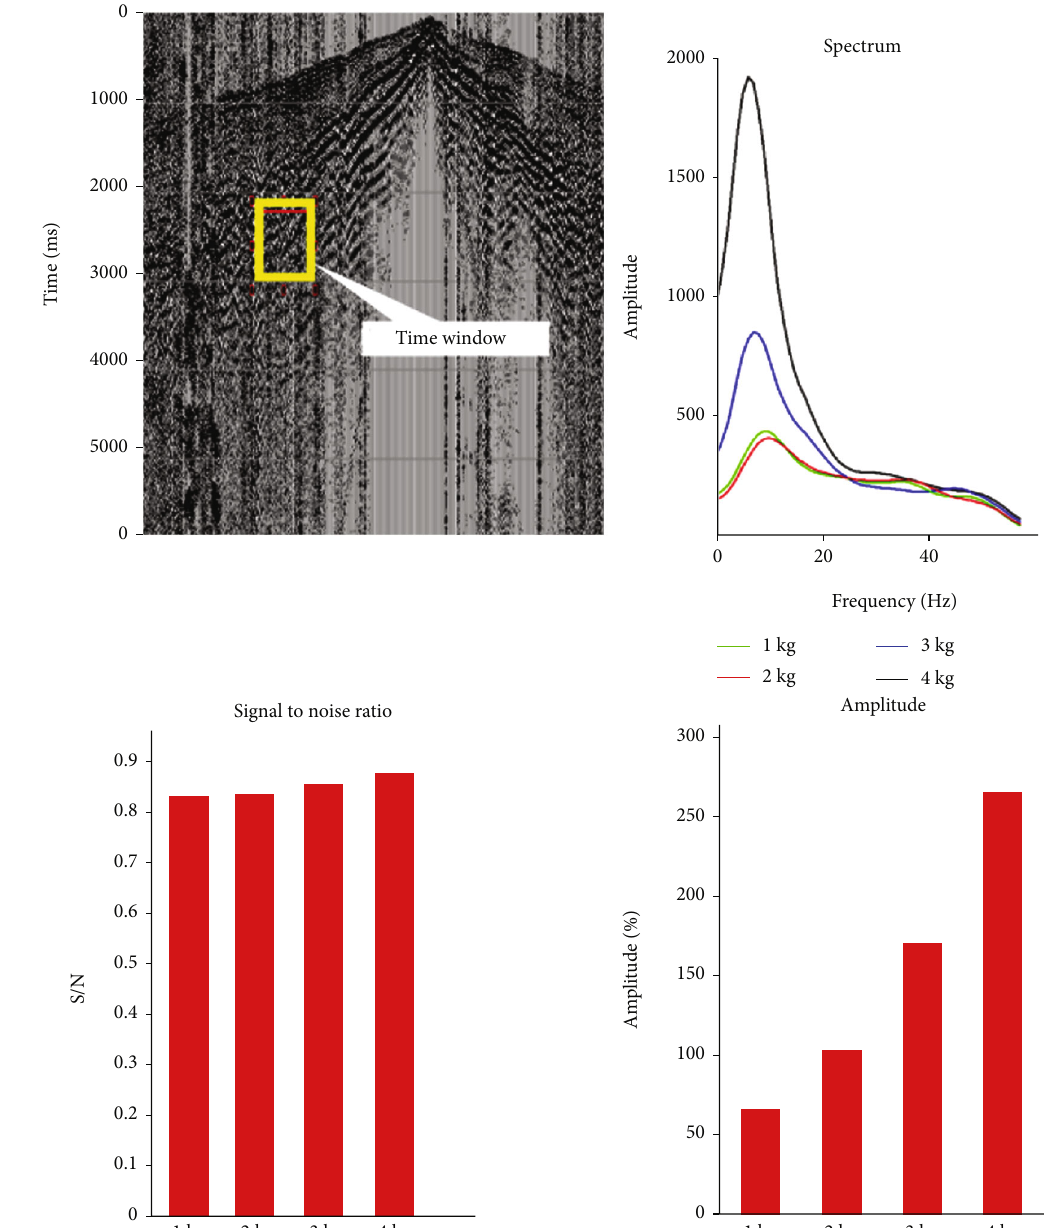
Figure 5: Quantitative analysis of smaller charge sizes with shallow source